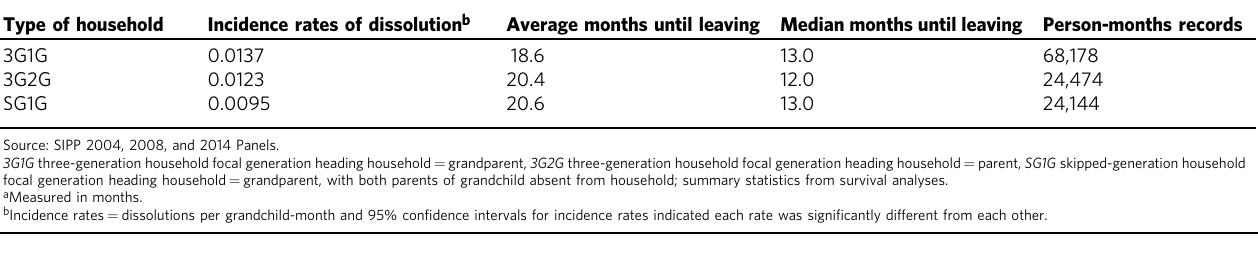
Table 3 Rare events logistic regression estimates of breakups among three intergenerational